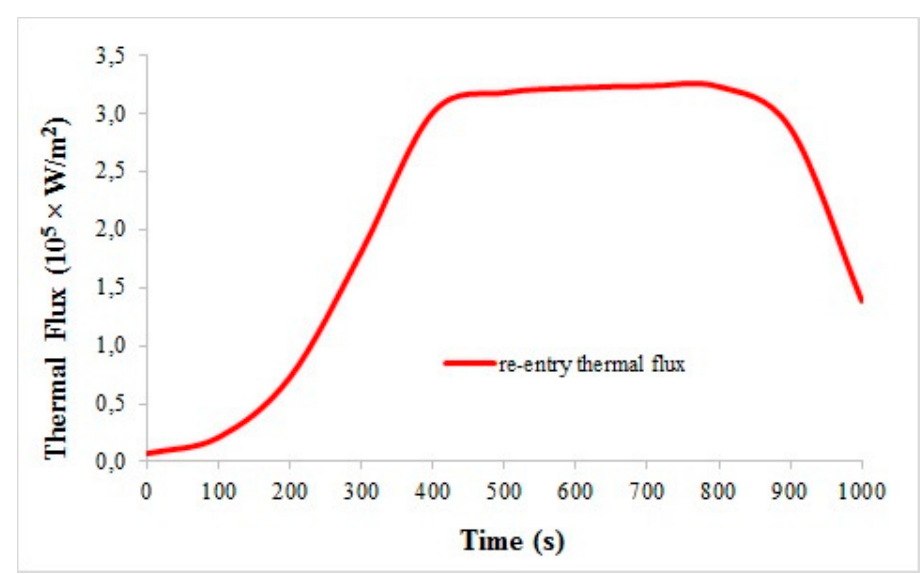
Figure 16. Thermal flux experienced by spacecraft during re-entry in earth atmosphere.